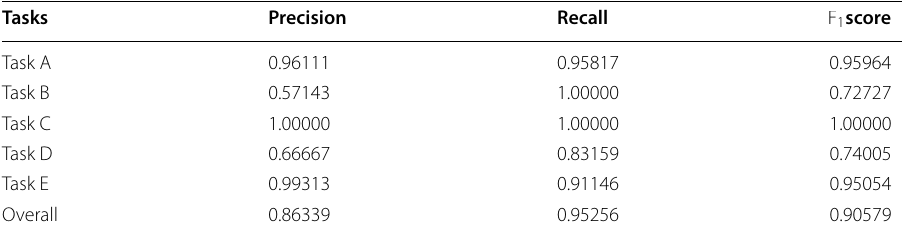
Table 5 Precision, recall and F 1 scores for word reordering detection Tasks Precision Recall